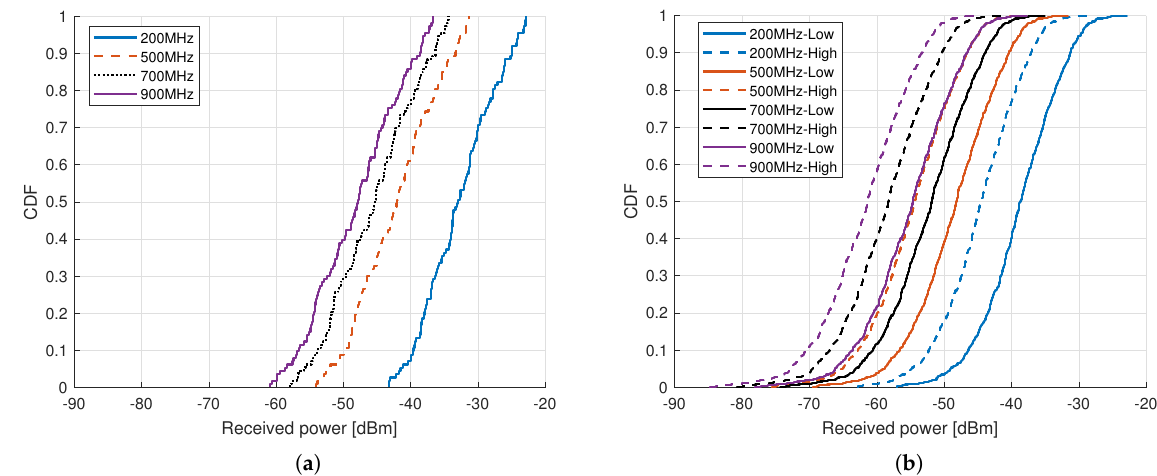
Figure 6. CDF of received power at backscatter device for different frequencies, ( a ) Outdoor, and ( b ) Indoor.